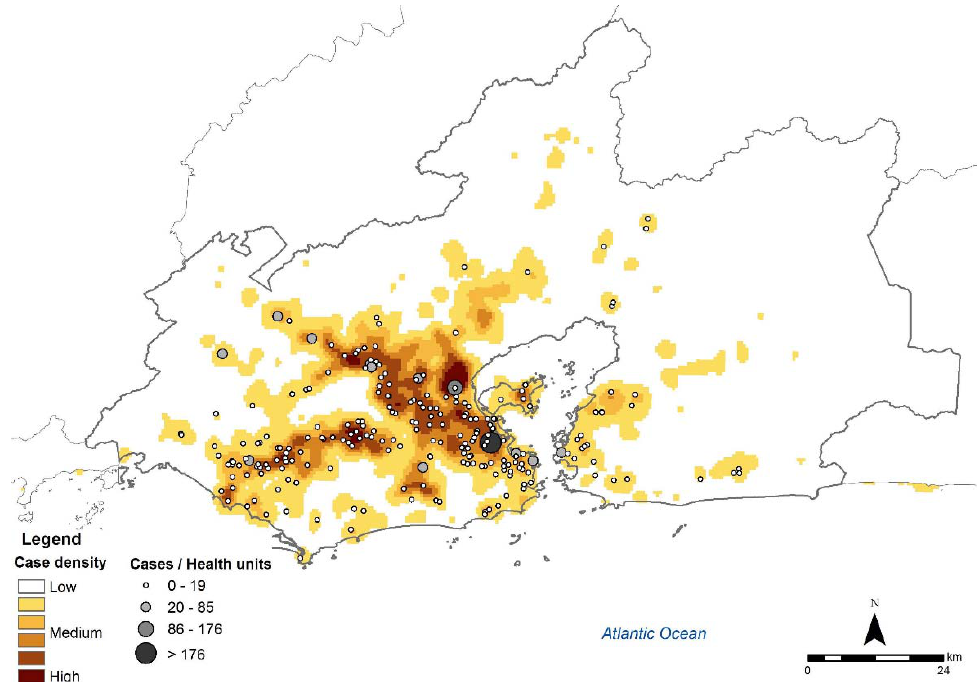
Figure 1. Cases of human sporotrichosis from 2008 to 2015 and notifying health units in the metropolitan region of the state of Rio de Janeiro (Source: SES ‐ RJ, Sipec, CNES. Limits of neighborhoods: Demographic Census 2010, IBGE. Map created by the authors).